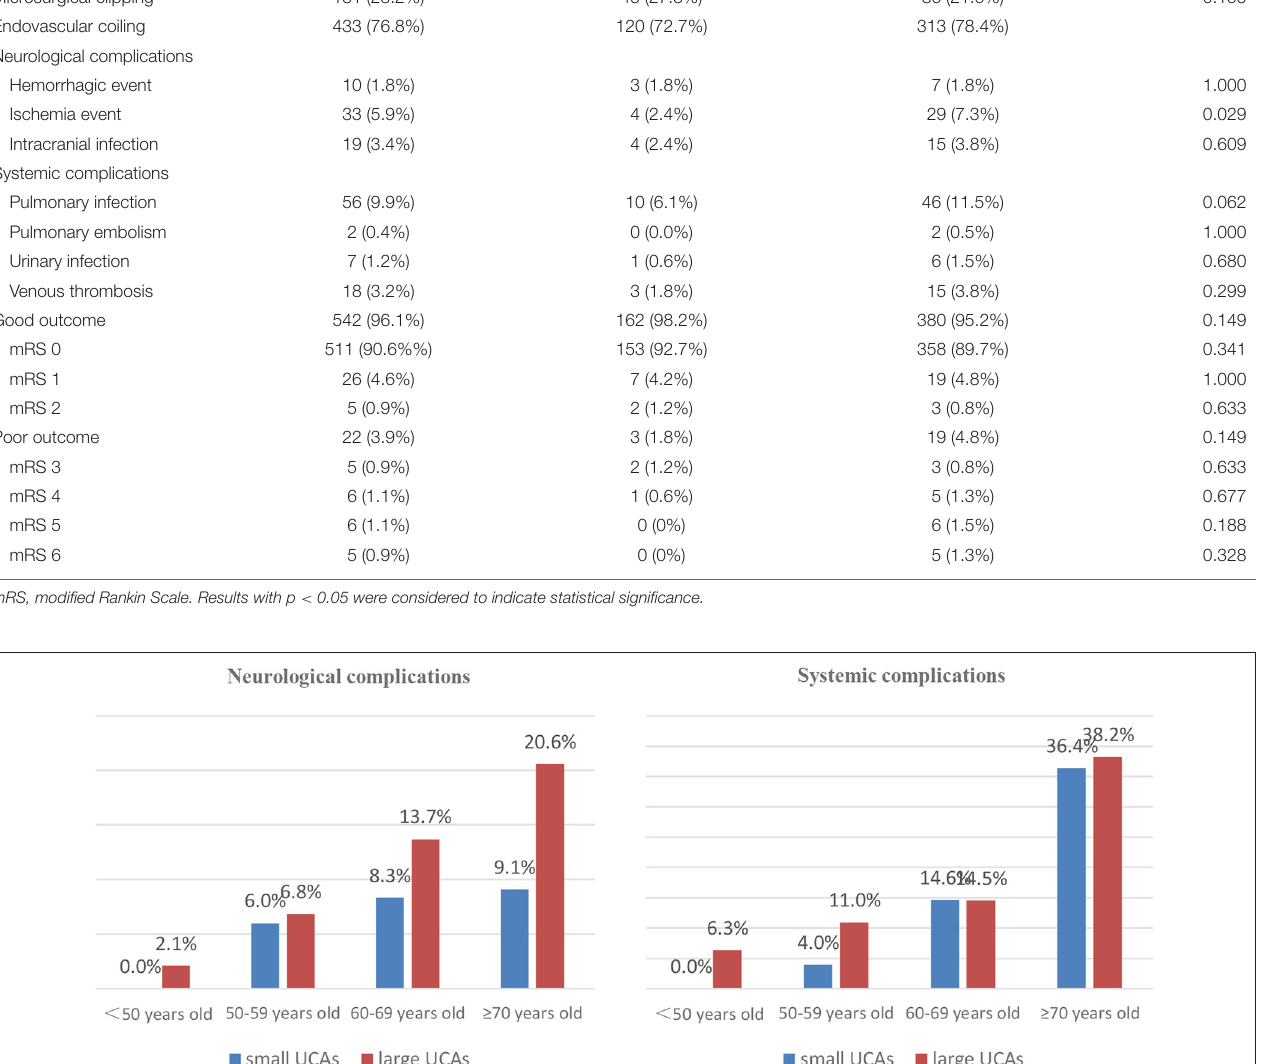
the large UCA group and three cases (0.8%) were retreated with endovascular